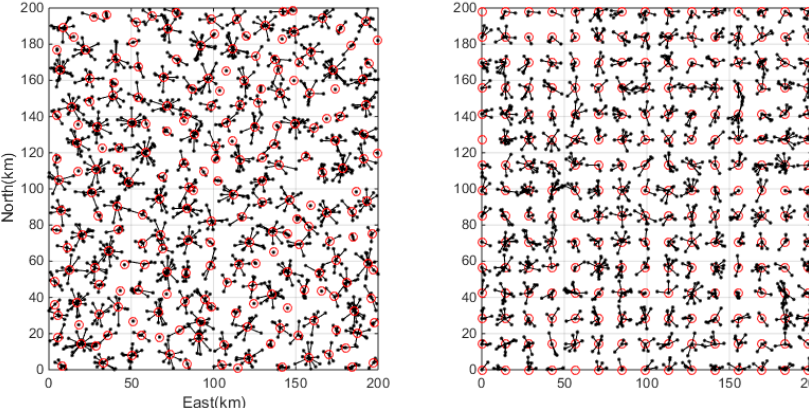
Figure 7. Clustering results with the SOSC ( left ) and grid ( right ) approaches for the uniform distribution case.